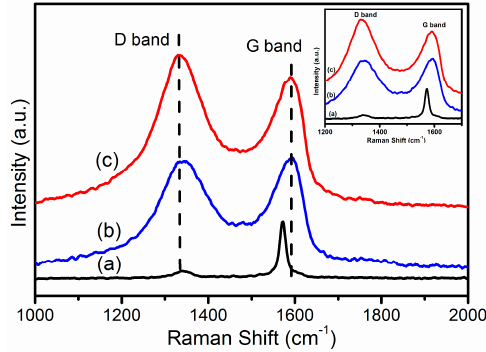
Figure 6. Raman spectra of ( a ) graphite, ( b ) GO and ( c ) GO-CS-PHGC.